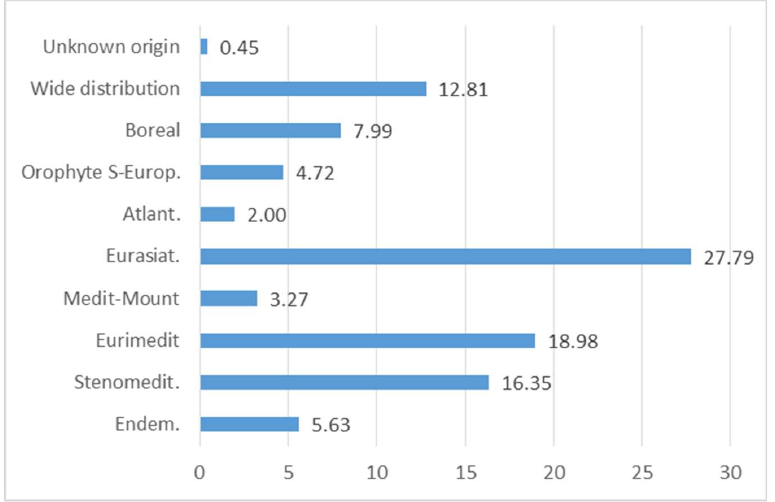
Figure 14. Percentage composition of the chorologic spectrum of Italian of Wild Edible Plants (WEPs).